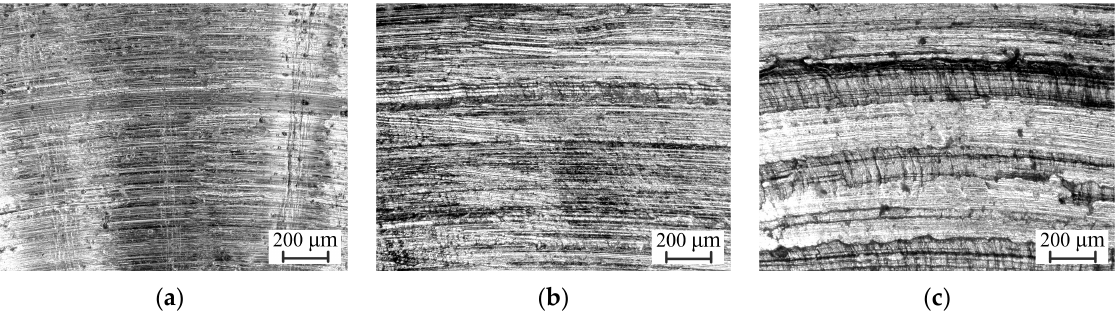
Figure 10. Morphology of the chip-extruded surface of the external tooth: ( a ) a drilled depth of 0.8 m, ( b ) a drilled depth of 7.2 m, ( c ) a drilled depth of 13.6 m.